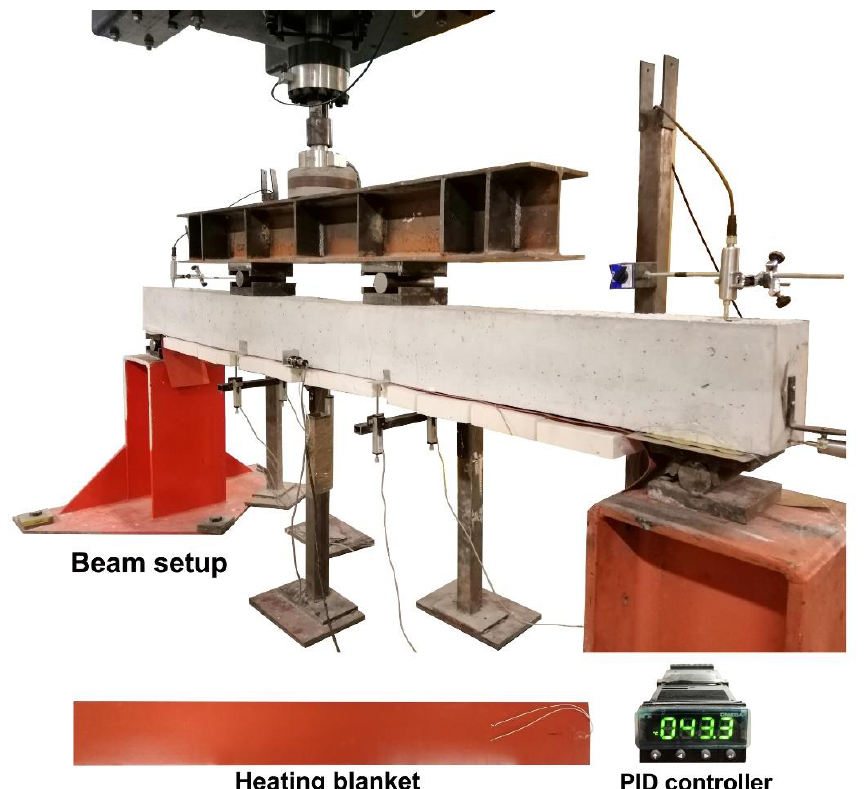
Figure 4. General overview of test scene and elements of the heating system.